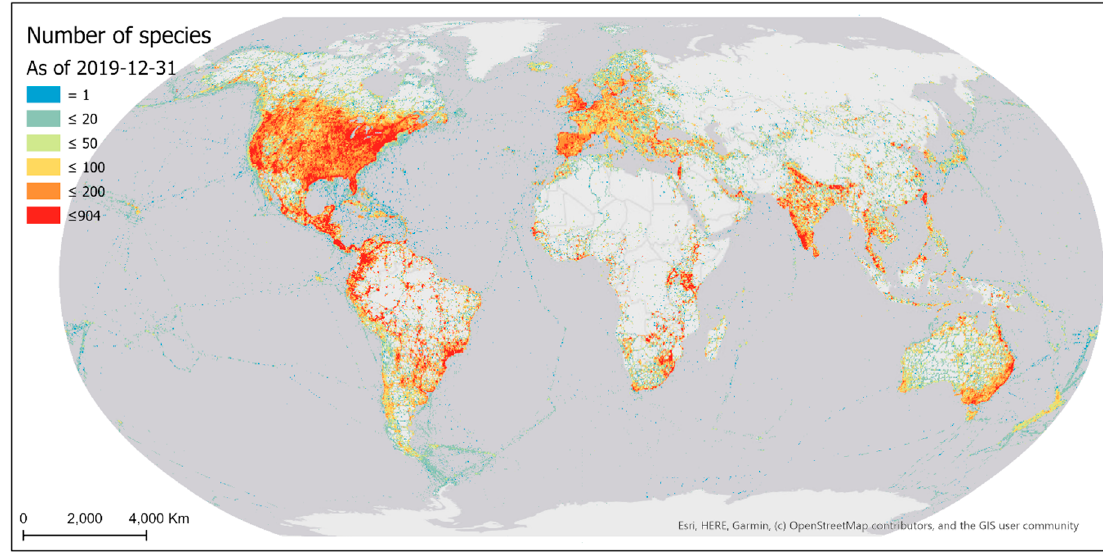
Figure 15. The cumulative number of species reported to eBird as of 31 December 2019 mapped over 0.25° latitude × 0.25° longitude grid cells. Intervals were determined loosely following quartile classification method.